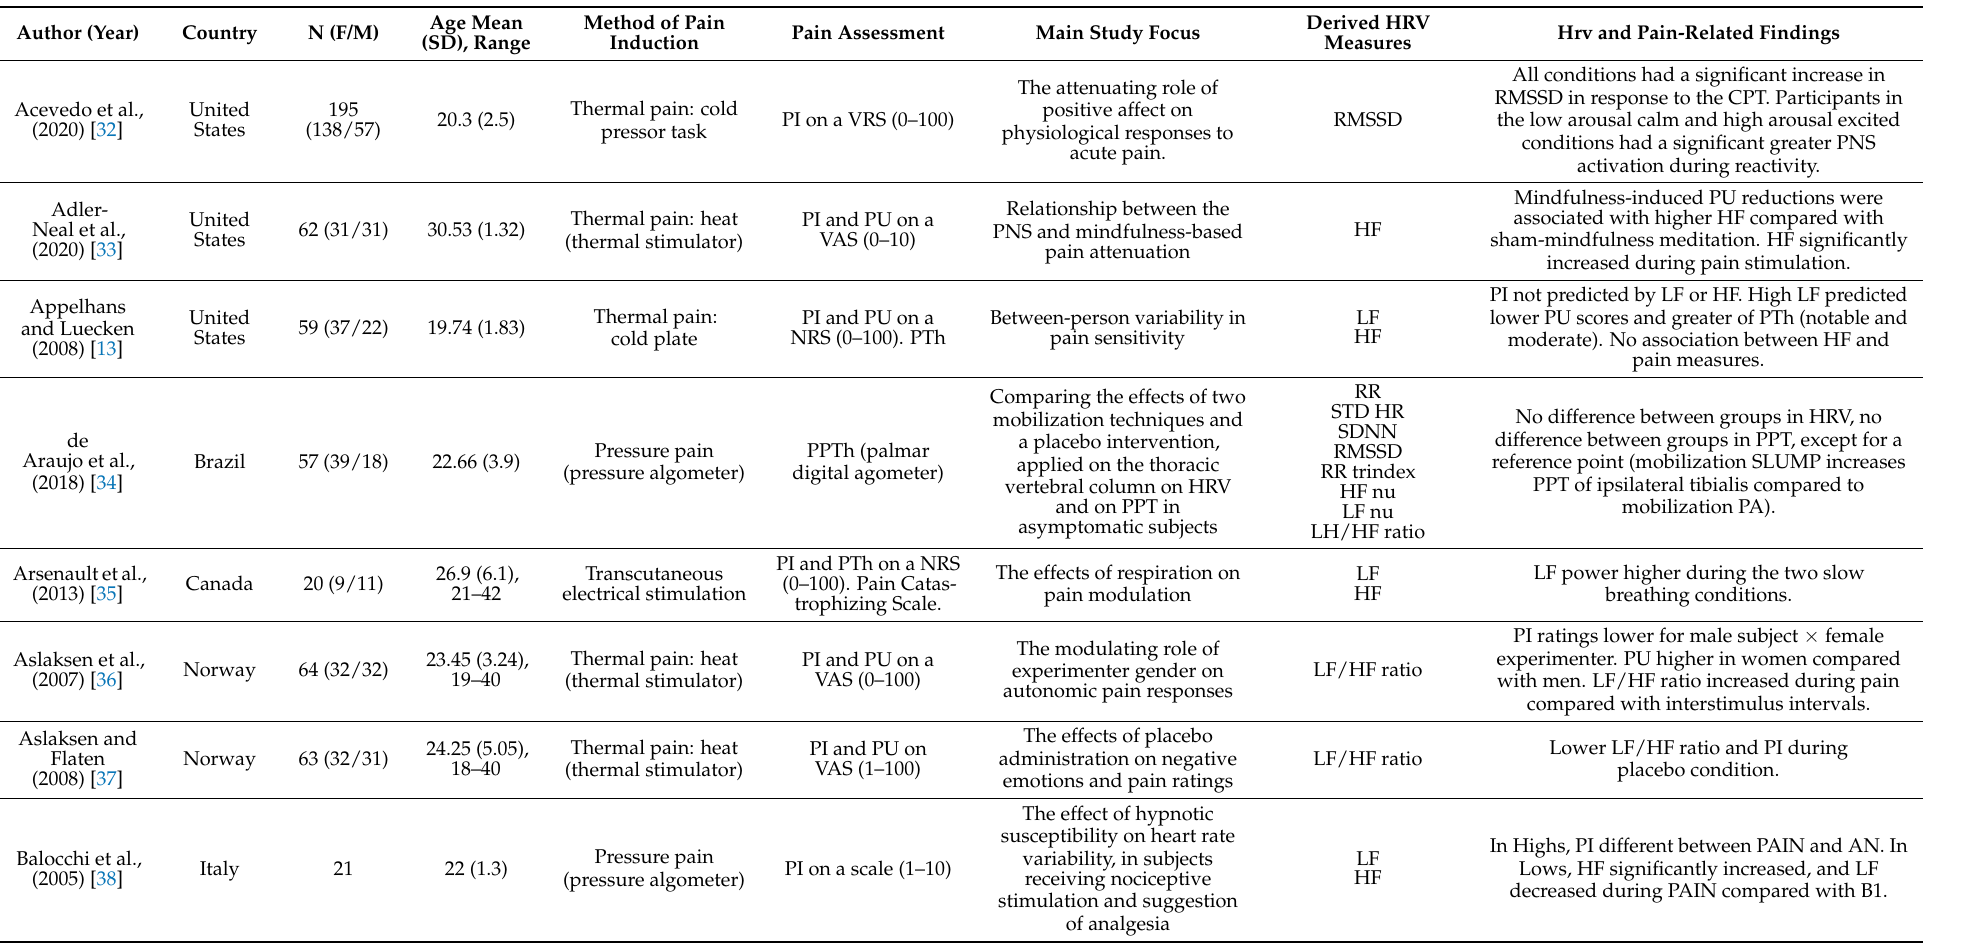
Table 1. Characteristics of selected